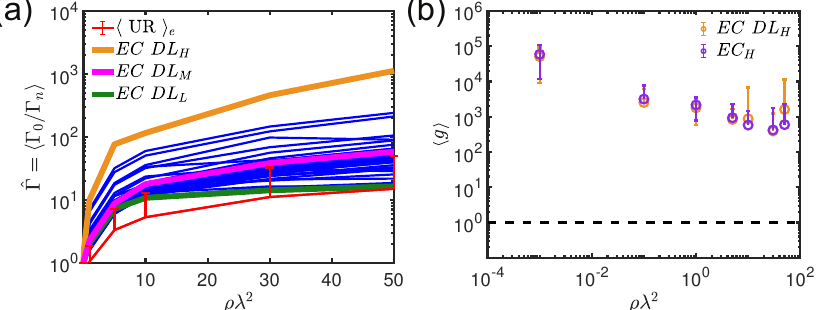
Figure 11. ( a ) Averaged modal lifetime as a function of different optical densities of 36 EC DL geometries generated by randomly selecting the point W from the EC H and EC L point patterns as compared to the uniform random configuration ensemble averaged over 10 different disordered realizations (red line). The highest ( EC DL H ), the middle ( EC DL M ), and the lower ( EC DL L ) ˆ Γ trends are highlighted in orange, cyan, and green colors, respectively. Specifically, EC DL H and EC DL M are the point patterns characterized by the coordinates ( M x ; k ) and ( M y ; k ) generated, respectively, by solving the discrete logarithmic problem W = kM associated to the EC H when W is equal to (375;1739) and (1902;389). EC DL L is, instead, generated by solving the discrete logarithmic problem W = kM x associated to the elliptic curve y 2 = x 3 + 28 x + 19 defined over the finite field F 2111 when the integer W is equal to (295;235). ( b ) Thouless conductance as a function of the scattering strength ρλ 2 averaged over the frequency stripe of width of 2 Γ 0 centered in ω 0 for the EC DL H (circle carrot orange markers) and EC H (circle violet markers) configurations, respectively. The dashed-black lines identify the threshold of the diffusion-localization transition g =